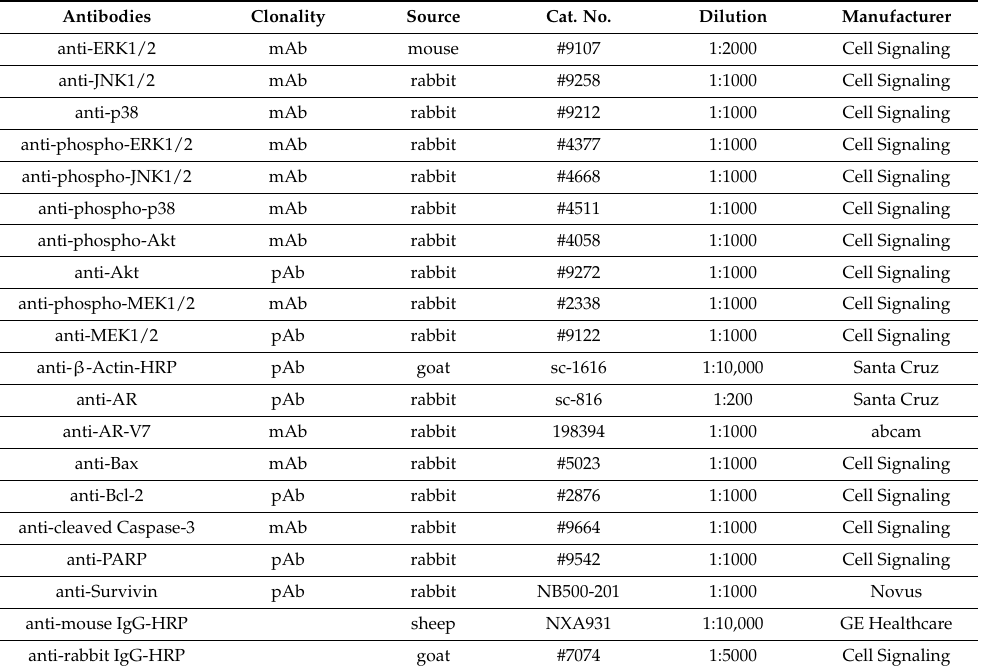
Table 3. List of antibodies